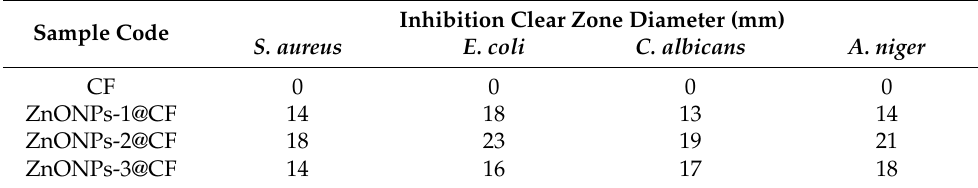
Figure 8. Inhibition zone evaluation of blank and ZnONPs@CF against pathogenic microbes. Table 1. The average diameter zone (mm) for the untreated cellulosic fabric and ZnONPs@CF against the tested pathogenic microbes.